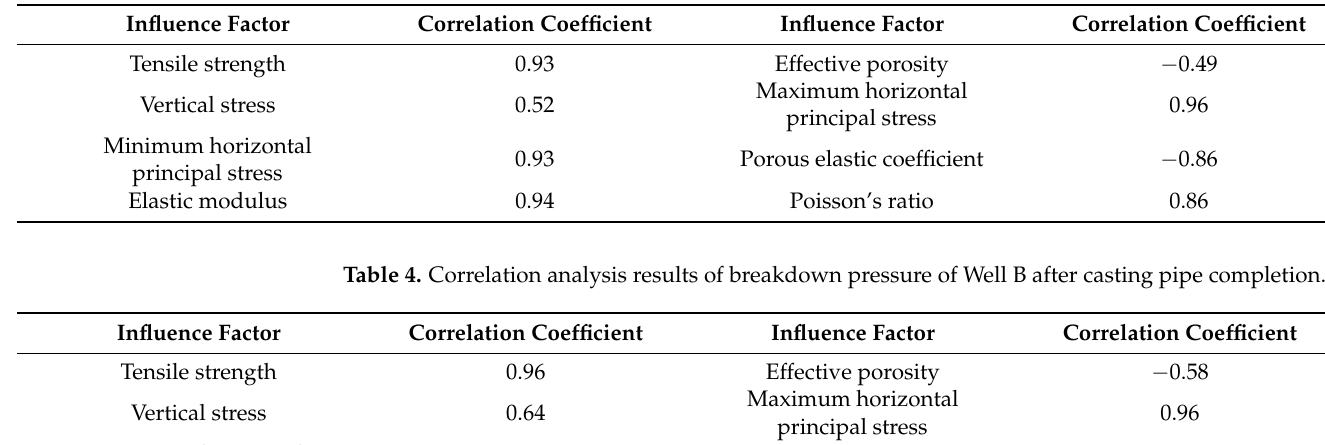
Table 3. Correlation analysis results for breakdown pressure of open hole completion Well A.